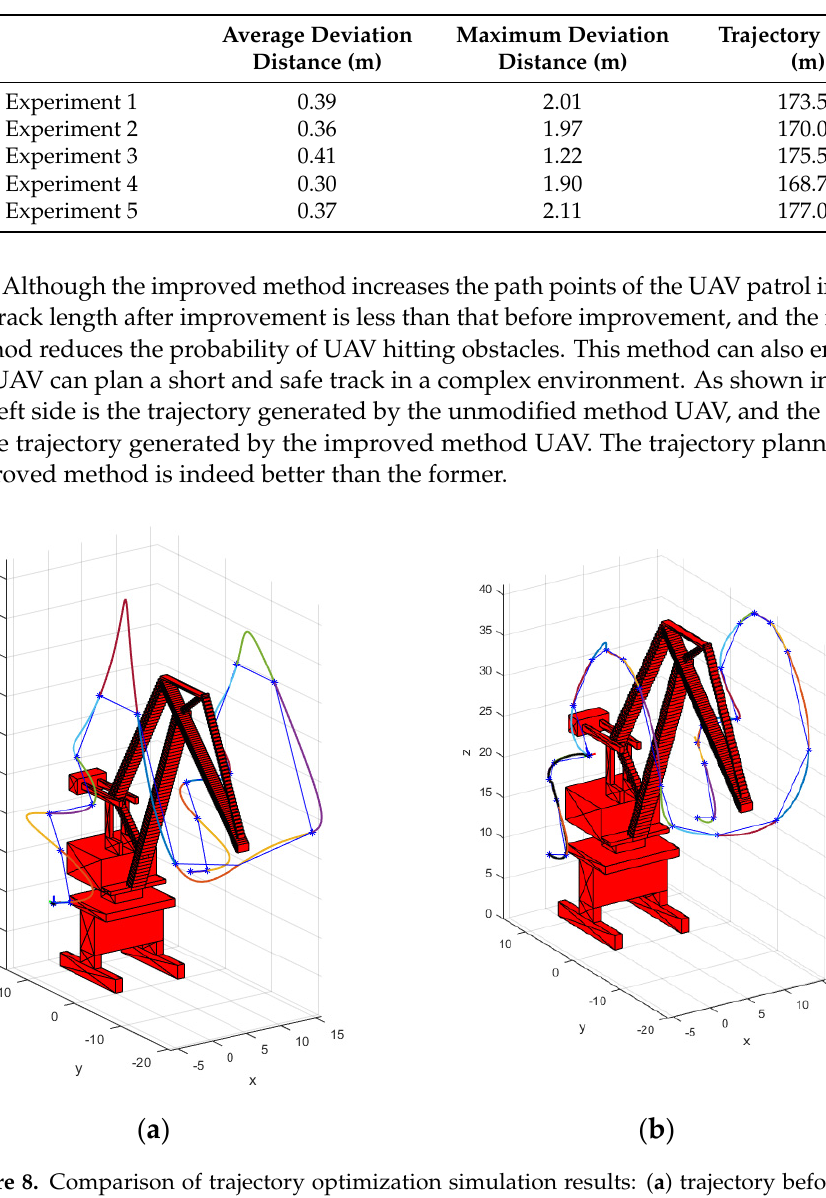
( b ) Figure 9. Comparison of UAV trajectory deviation before and after improvement: ( a ) improvements to previous UAV trajectory deviations; ( b ) improved UAV trajectory deviation. Table 3. Comparative experiments results.